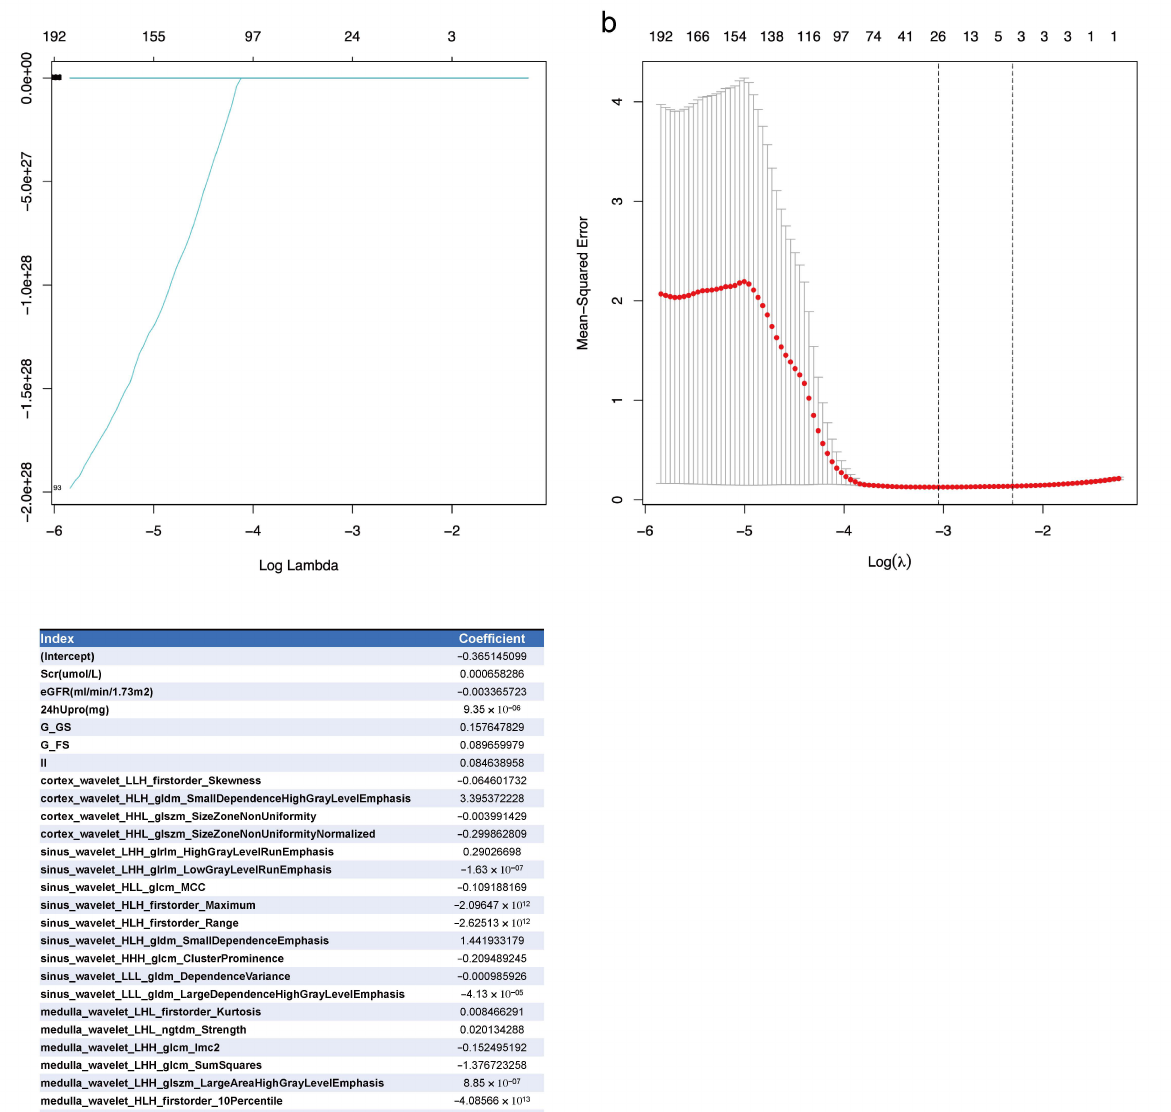
Figure 2. Lasso regression of feature selection from the clinical index, pathological changes, ultra- sound parameters, and radiomics signatures for CKD prognosis. ( a ) Lasso coefficients of all features. Log lambda ( λ ) represents the regularization penalty parameter; ( b ) cross-validation to select the op- timal parameter λ . The optimal number of features was 26; the minimum value is represented by red dotted vertical lines. The two dotted gray lines represent the standard deviation. ( c ) The 26 selected features and their coefficients. Scr, serum creatinine at baseline; eGFR, eGFR at baseline; 24hUpro, twenty-four-hour total urinary protein; G_G_Sclerosis, Glomerular_Global Sclerosis; G_FS_Sclerosis, Glomerular_Focal Segmental Sclerosis; II, interstitial